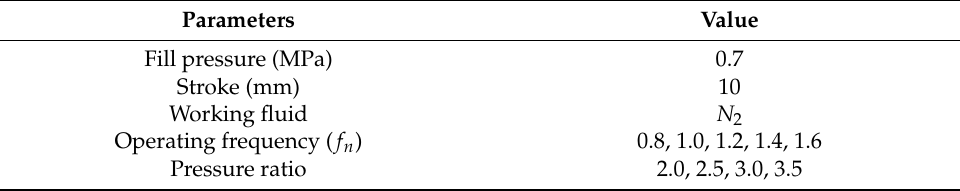
Table 5. The system operating parameters.